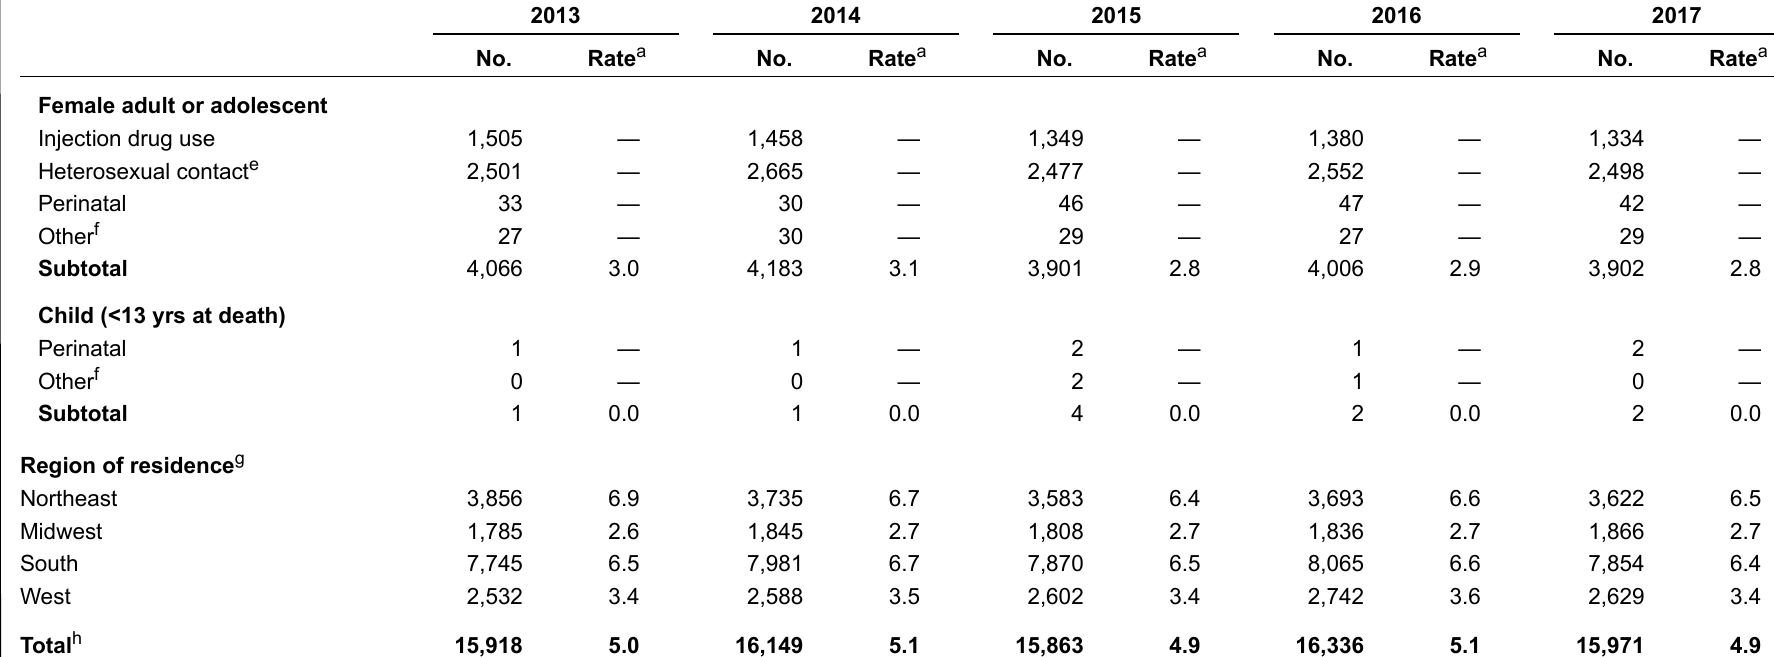
Table 18a. Deaths of persons with diagnosed HIV infection, by year of death and selected characteristics, 2013–2017—United States